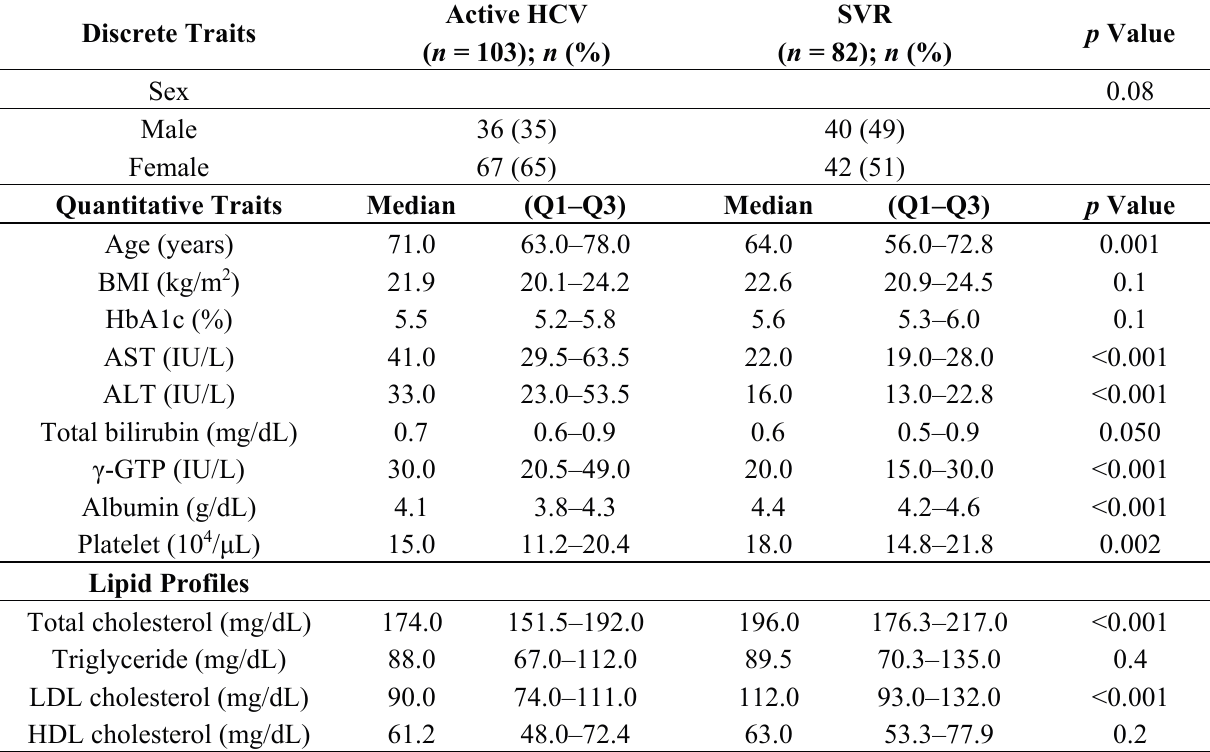
Table 1. Comparison of clinical features between patients with chronic active HCV G1b infection (active HCV) and cleared HCV infection